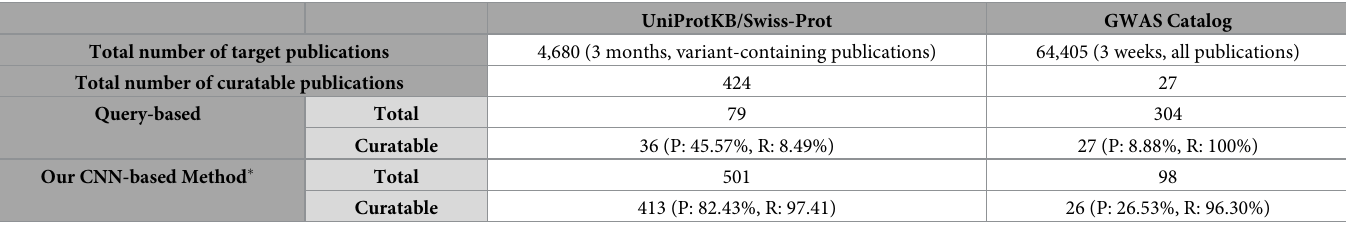
Table 3. Comparison of the results of our method with those of the query-based method in the UniProtKB/Swiss-Prot and GWAS Catalog triage. Both query-based and CNN-based results were evaluated by the curators, resulting in the total number of curatable publications